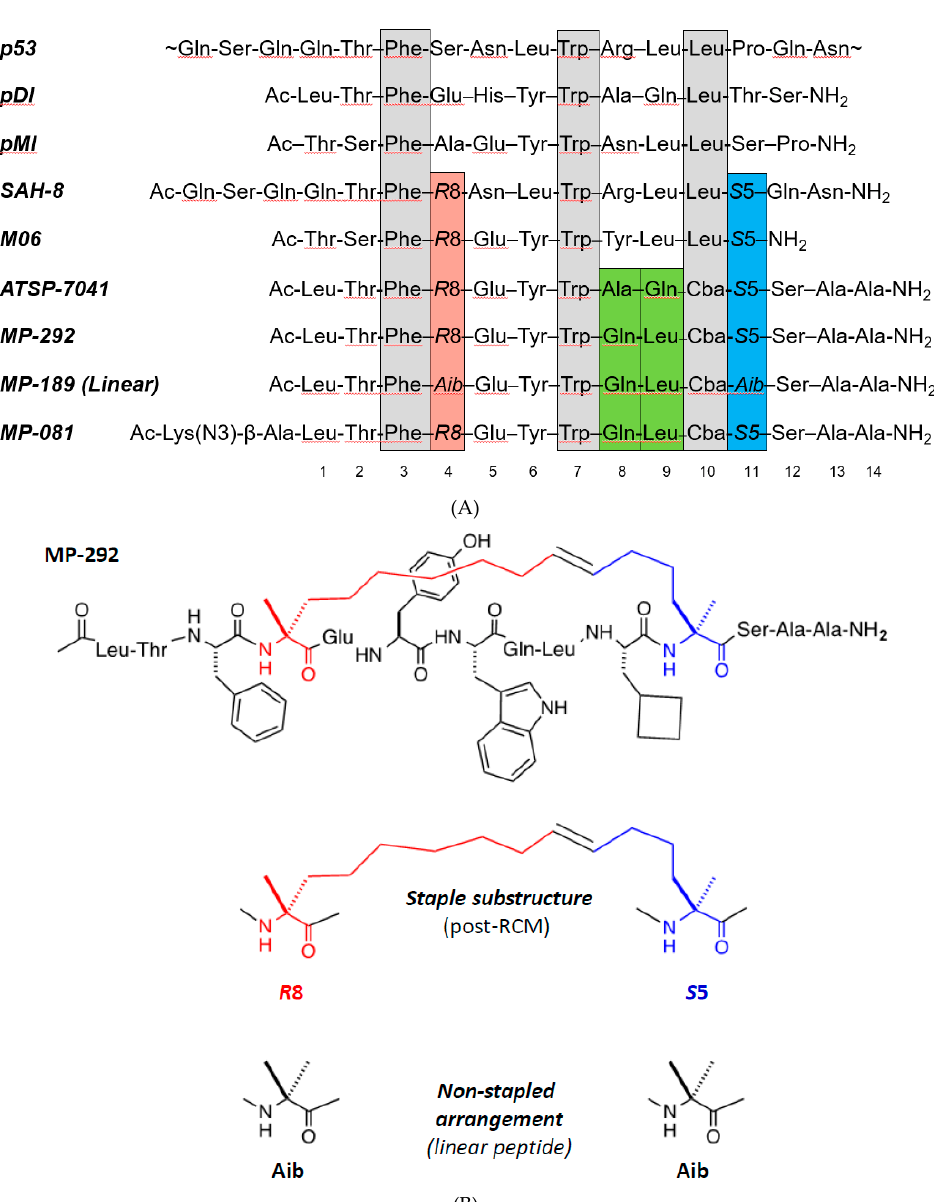
Figure 1. Template sequences used in this study and comparison to related literature peptides. ( A ) Sequences of p53; phage display peptides pDI and pMI; literature stapled peptides SAH-8, M06, and ATSP-7041; and ATSP-7041 variants used as template sequences in this work, MP-292, MP-189, and MP-018. ( B ) Chemical structure of MP-292, as well as the substructure of the stapling amino acids ( R 8 and S 5) and